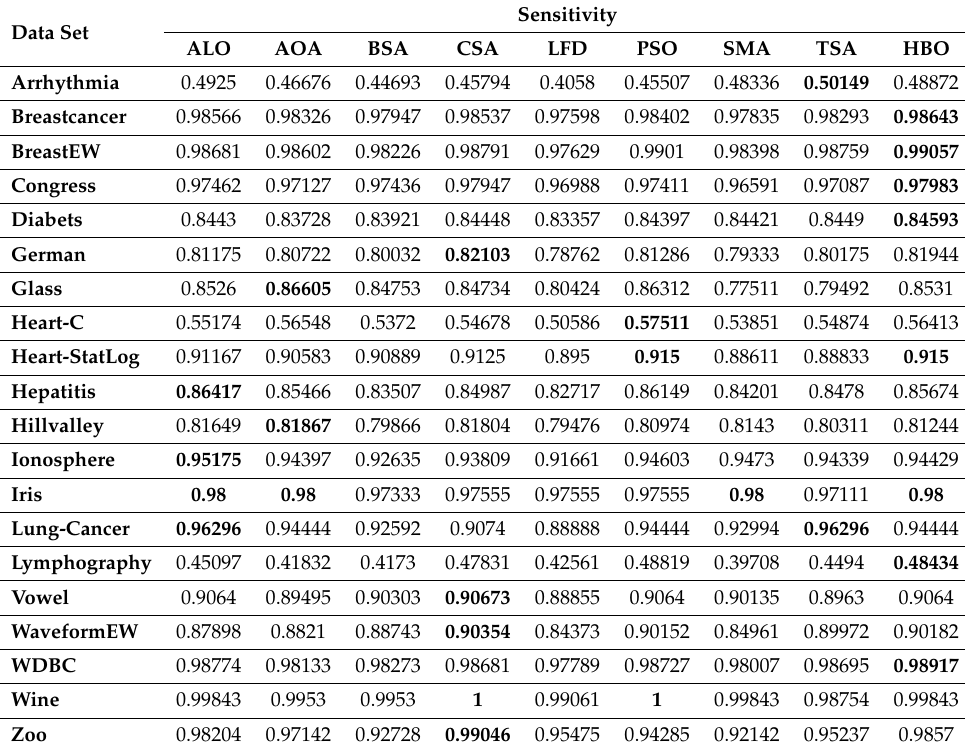
Table 7. The average Sensitivity of B_HBO against other recent